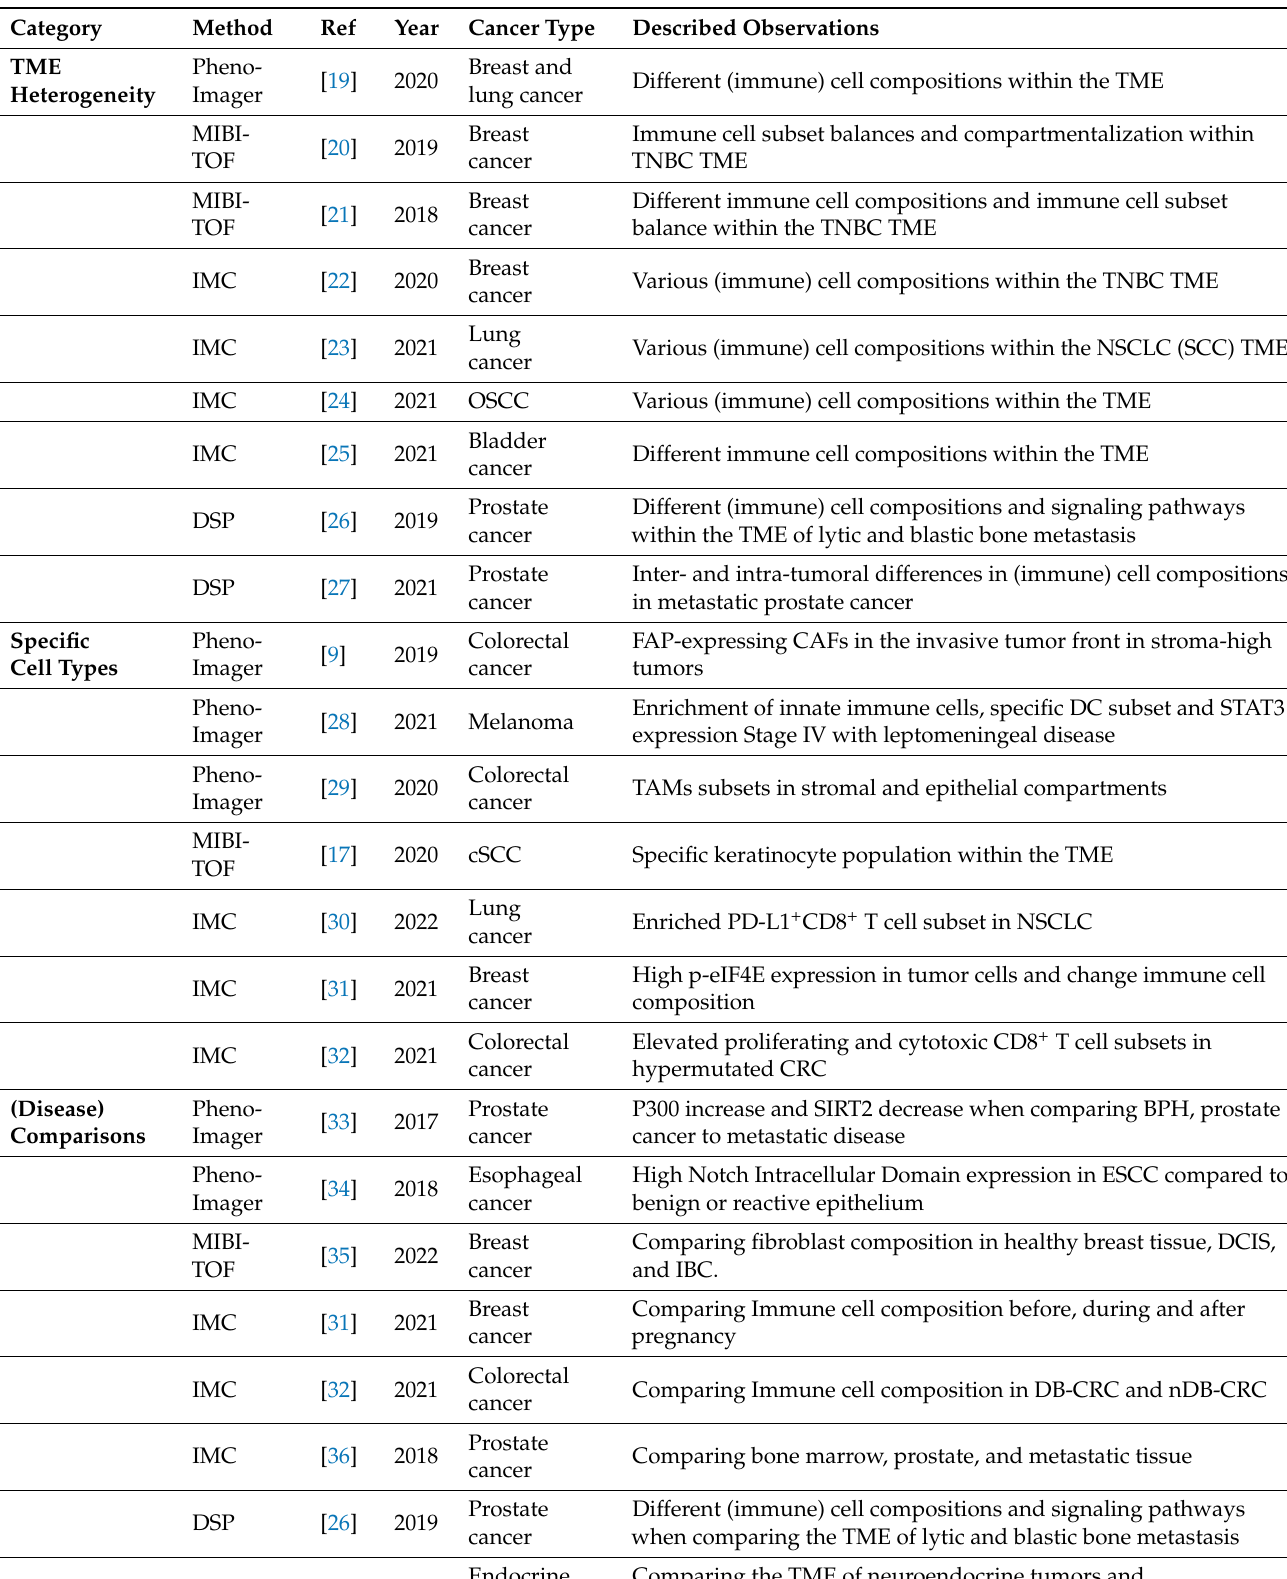
Table 2. Summary table of multiplex imaging studies that describe tumor microenvironment hetero- geneity, specific cell types, novel immune cell subsets, cellular interactions, or (disease)